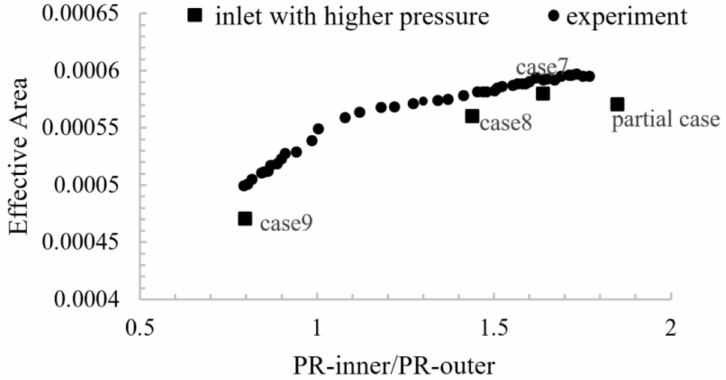
Figure 4. Effective area versus pressure ratio.